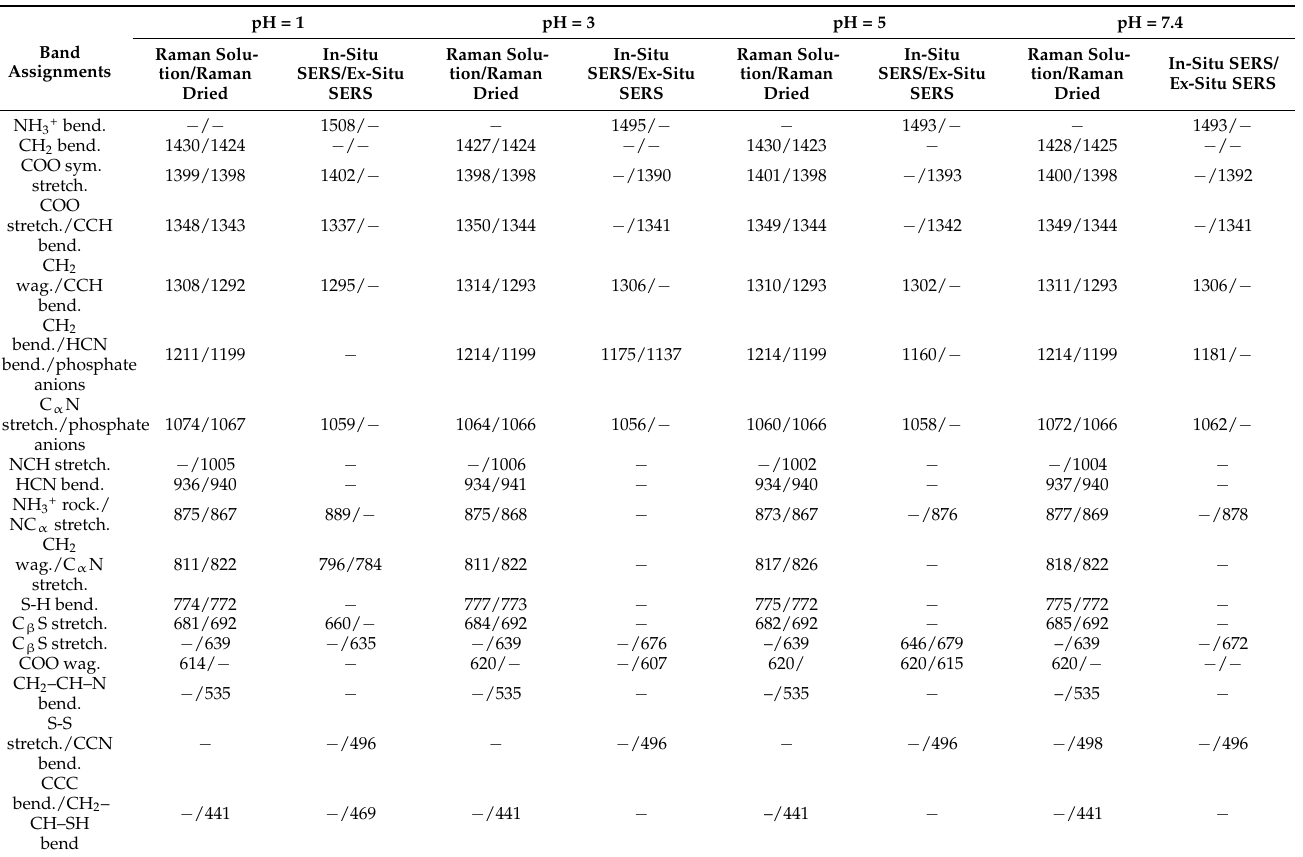
Table 1. Proposed band assignments for Raman spectra for Cys in solution and solid states at pH =1, 3, 5, and 7.4 and recorded in the Cys/Ti in situ and ex situ system.